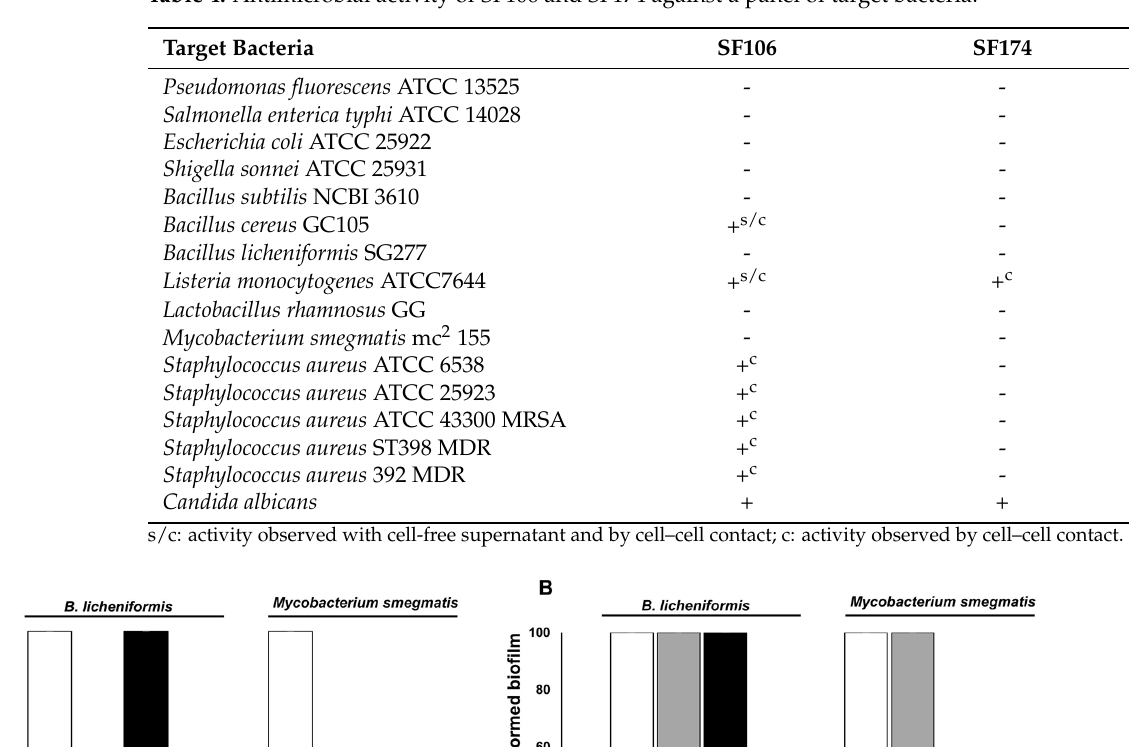
Table 5. Minimal Inhibitory Concentration (MIC) of selected antibiotics against SF106 or SF174.